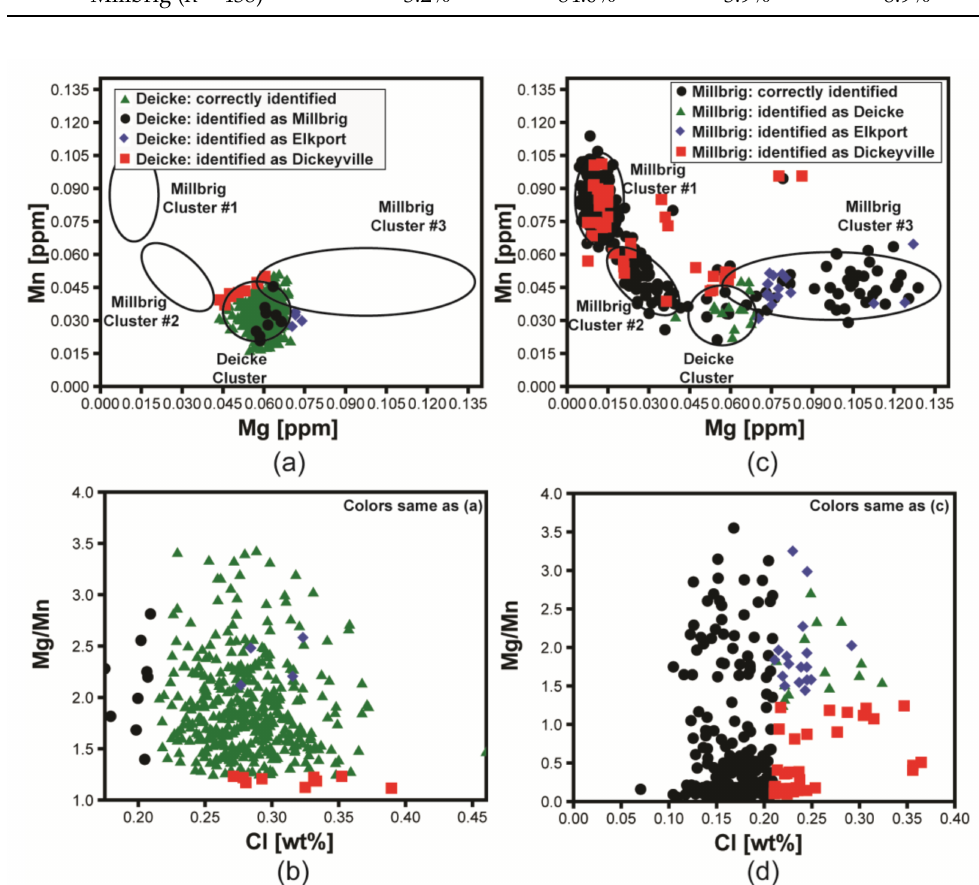
Figure 4. Identification of misidentified Deicke and Millbrig samples from the dataset of Carey et al. [14] using the dataset of Emerson et al. [15] as the training dataset. ( a ) Clustering of Deicke samples in Mg-Mn space; ( b ) Clustering of Deicke samples in Cl—Mg/Mn space. ( c ) Clustering of Millbrig samples in Mg-Mn space; ( d ) Clustering of Millbrig samples in Cl—Mg/Mn space. The misidentifications are due to offsets in Cl, Mn, and Mg concentrations were chosen by the ML algorithm as cut-offs. In particular the Cl concentration cut-off at 0.21 leads to the most misidentified Millbrig as well as misidentified Deicke samples. The Millbrig and Deicke clusters shown in ( a , c ) are from Carey et al. [14]. Mn and Mg concentrations are in PPM and Cl concentration is in weight